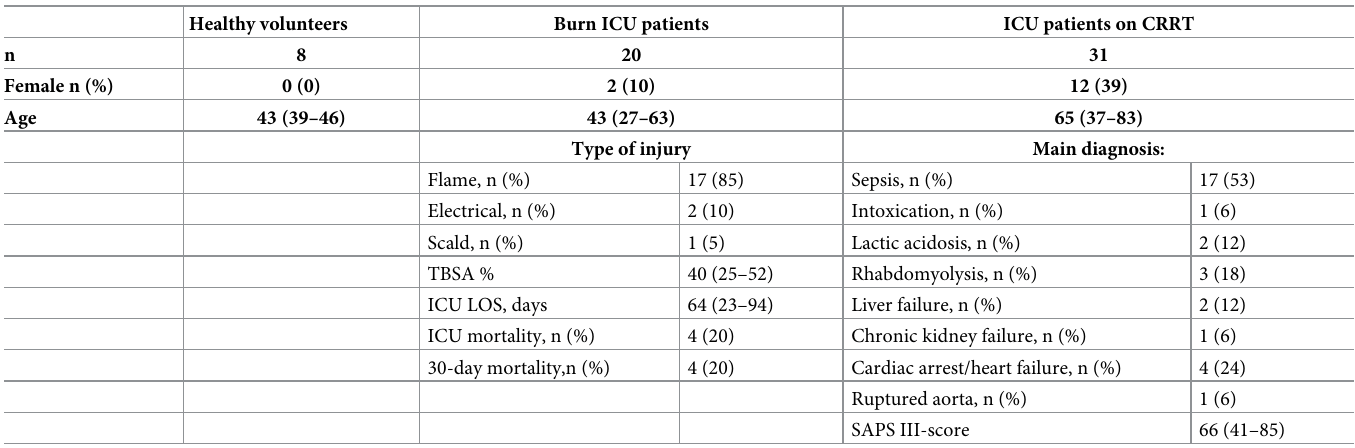
Table 1. Characteristics of patients.